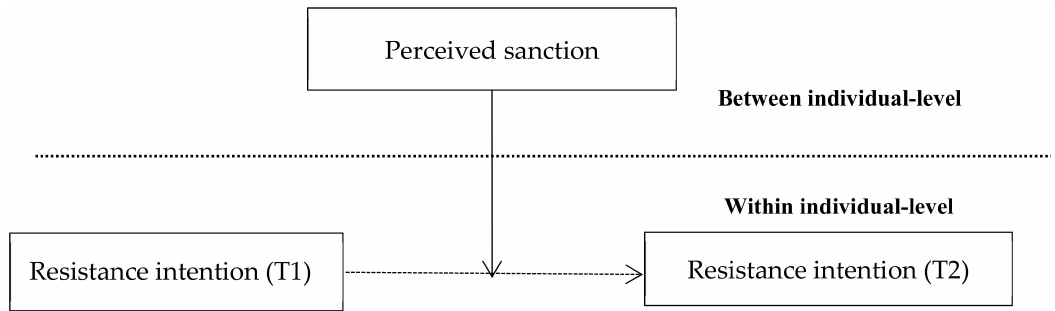
Figure 2. Schematic diagram of a multilevel linear growth